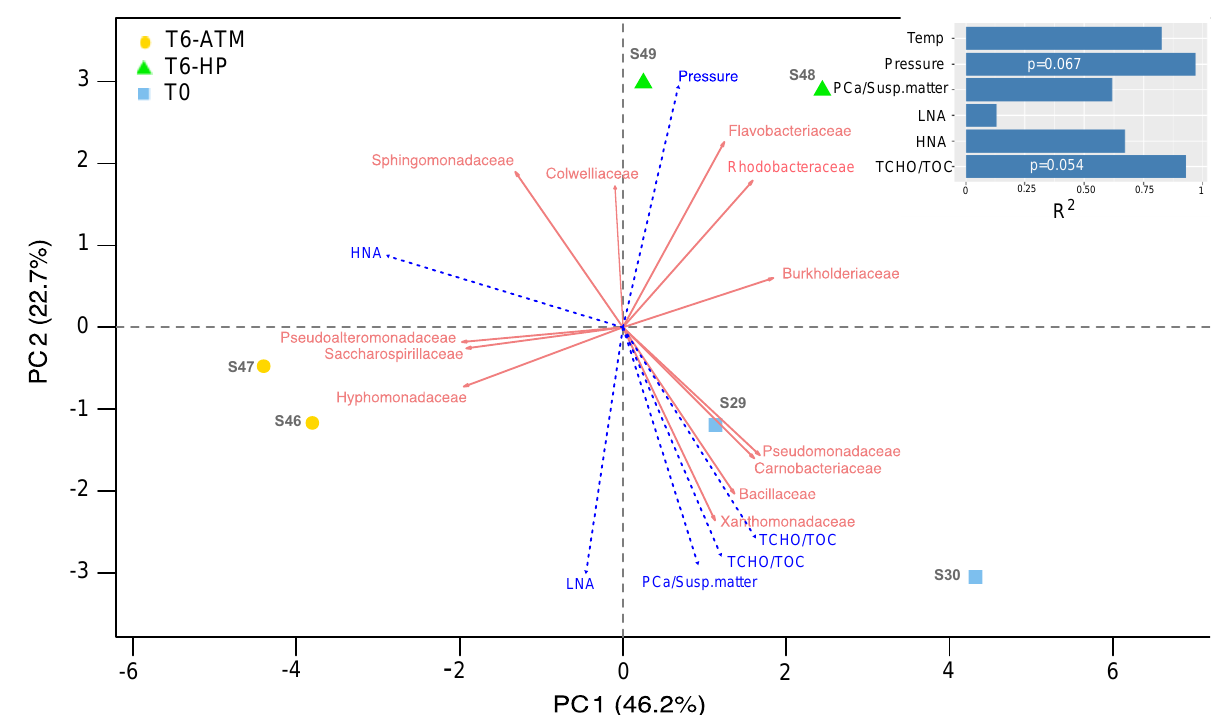
Figure 5. Principal component analysis (PCA) biplot of samples and the most contributing taxonomic families (based on fviz_contrib function of factoextra from stats v3.6.2 R package). Samples are indicated as yellow circles (T6-ATM), green triangles (T6-HP), or blue squares (T0), whereas taxonomic families are indicated as red vectors. The magnitude of red vectors indicates the strength of their contributions to each PC axis. Vectors pointing in similar directions indicate positively correlated variables, vectors pointing in opposite directions indicate negatively correlated variables. The environmental variables were fitted as blue vectors (dashed lines) onto PC using envfit function from stats R package by calculating multiple regression with R 2 scores and p -values (top right of the Figure).